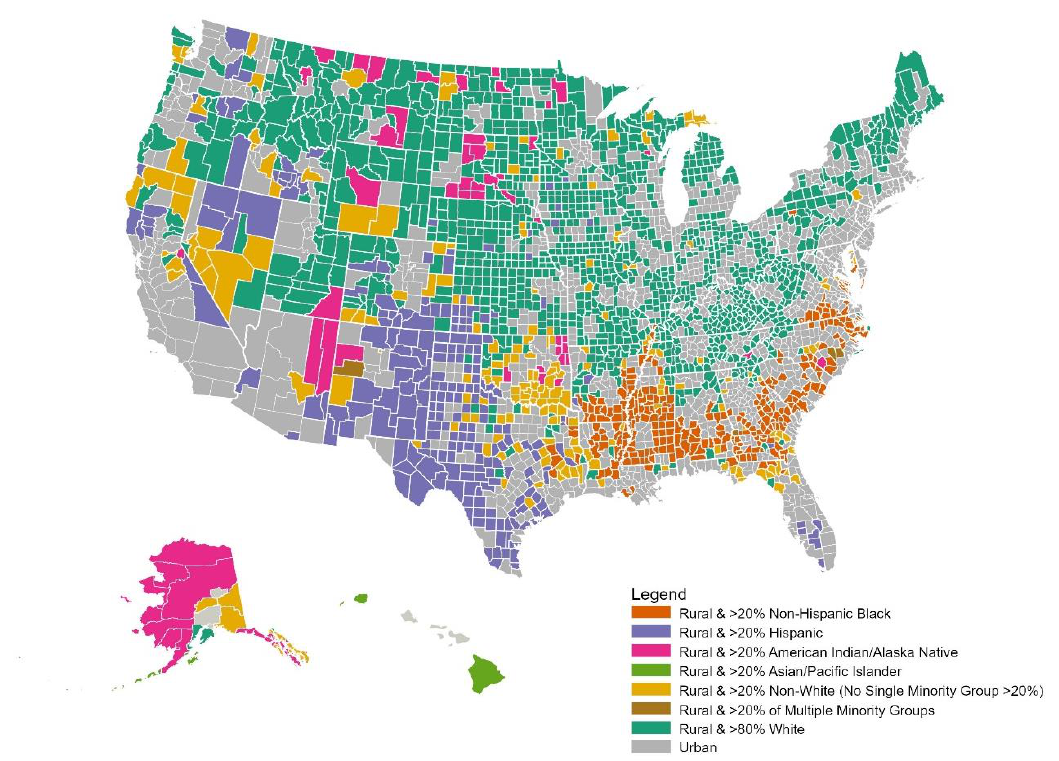
Figure 1. Racial/ethnic composition across rural counties, 2018. Rural and urban counties are defined by the non-metro and metro designations from the United States Department of Agriculture [30]. Racial/ethnic composition by county is based on the 2018 Census Bureau Population Estimates Program [31].